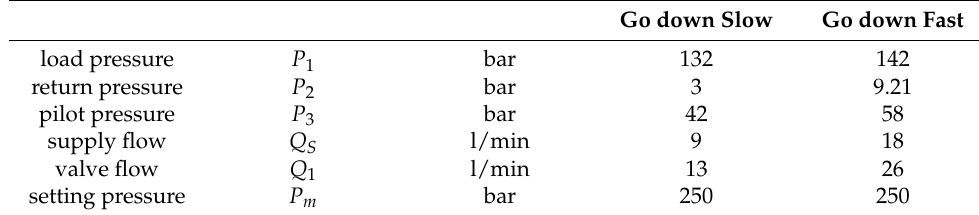
Table 4. Working values.